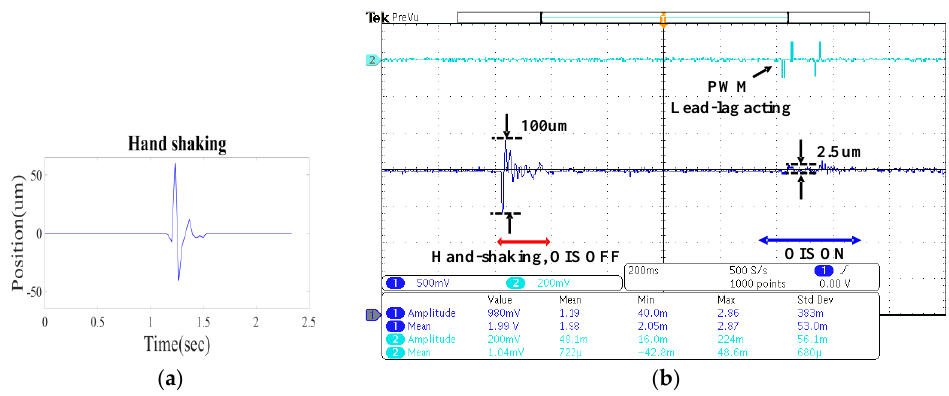
Figure 13. The OIS controller performance under a practical hand shaking; ( a ) The measured hand- shaking as input to the shaker; ( b ) the measured motion of the lens holder in OIS.